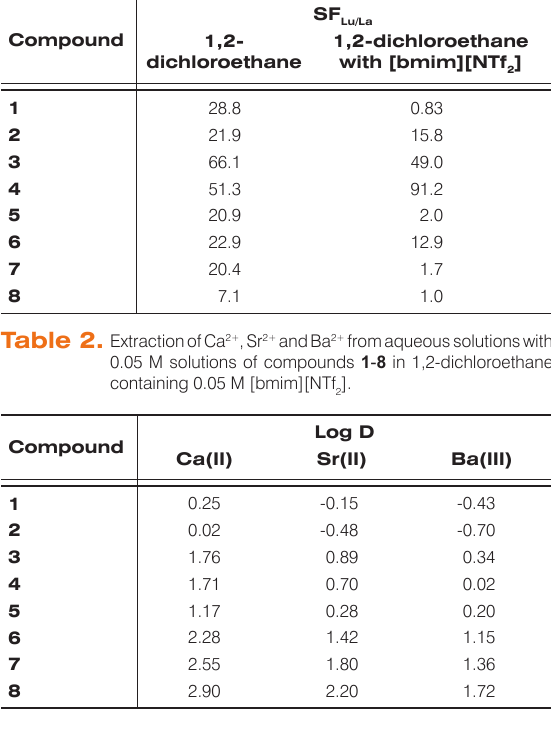
concentration of these free extractants. Nevertheless, compound 8 bearing six phosphoryl groups is the more effective extractant than its counterpart 7 having only three P=O functions. Table 1 lists the separation factors (SF =D /D ) between Lu and La, defined as the Lu/La Lu La ratios of the respective distribution ratios. It is obvious